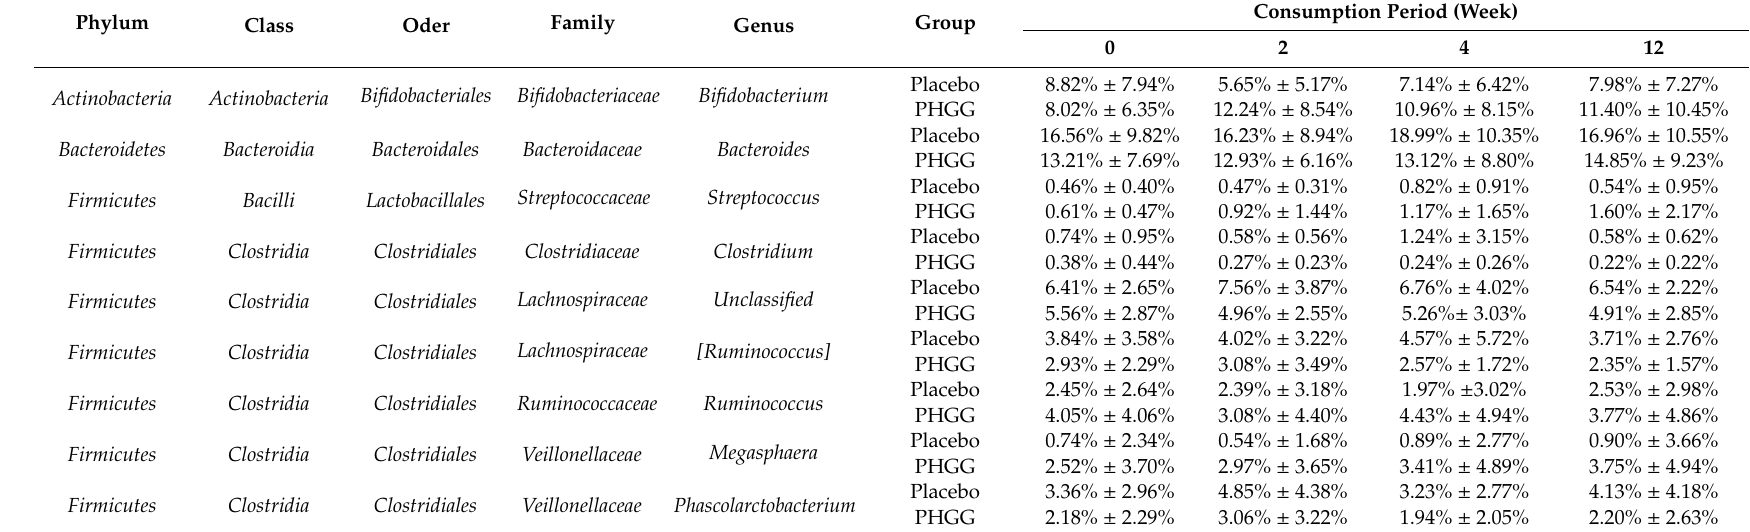
Table 3. Relative abundance of bacterial genera in the fecal microbiota of each group at each consumption